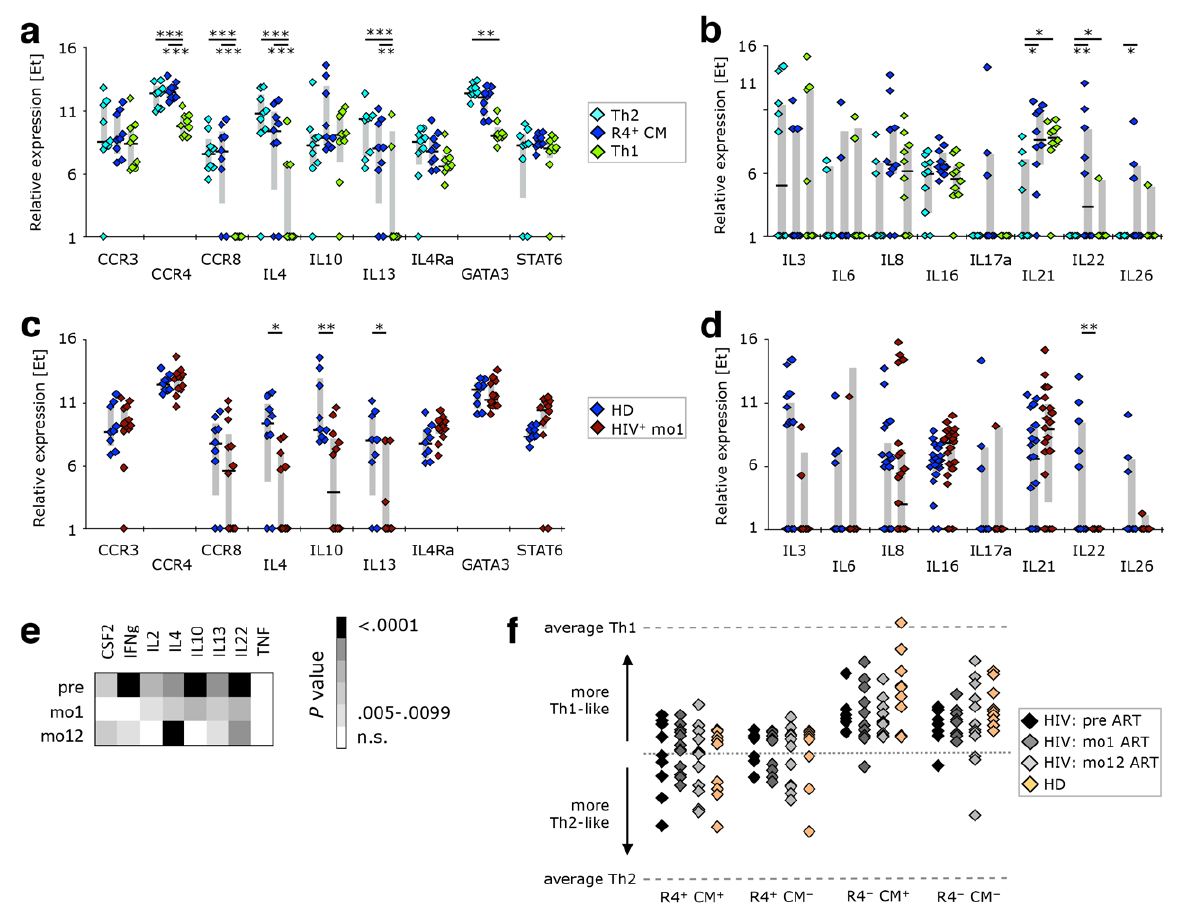
Figure 5. The gene expression profile of CCR4 + T is different from that of Th -like cells. PBMC from CM 2 healthy donors, as well as cells isolated before or after 1 or 12 months of ART from HIV-1-infected adults were stained with the “sorting” panel (Supplementary Table 1). Subsets of CD4 + T cells were sorted as indicated in Supplementary Figure 4 and their gene expression profiles determined by multi-parametric quantitative RT-PCR. (A) Th -associated and (B) other cytokine genes were compared in Th -like, CCR4 + 2 2 T , and Th -like cells isolated from healthy donors. CCR4 + T from HIV-1 + patients after 1 month of CM 1 CM ART were compared to their counterparts from healthy donors in respect to expression of (C) Th -asso- 2 ciated or (D) other cytokine genes. (E) The expression profile of cytokine genes was investigated in non- naïve cells. Relative expression in HIV-1-infected individuals before ART, after 1 month of ART, or 1 year of ART was compared to that in healthy donors. (F) The overall gene expression pattern of CCR4 + T , CM CCR4 + T CM− , CCR4 − T , and CCR4 − T CM− cells was compared to that of Th - or Th -like cells sorted from CM 1 2 healthy donors. Their calculated “Th-ness” is expressed as a point between those two extremes. Bar graphs show interquartile ranges, median bars, as well as individual data points. Statistically significant differences are indicated: * P < 0.01, ** P < 0.001, *** P <